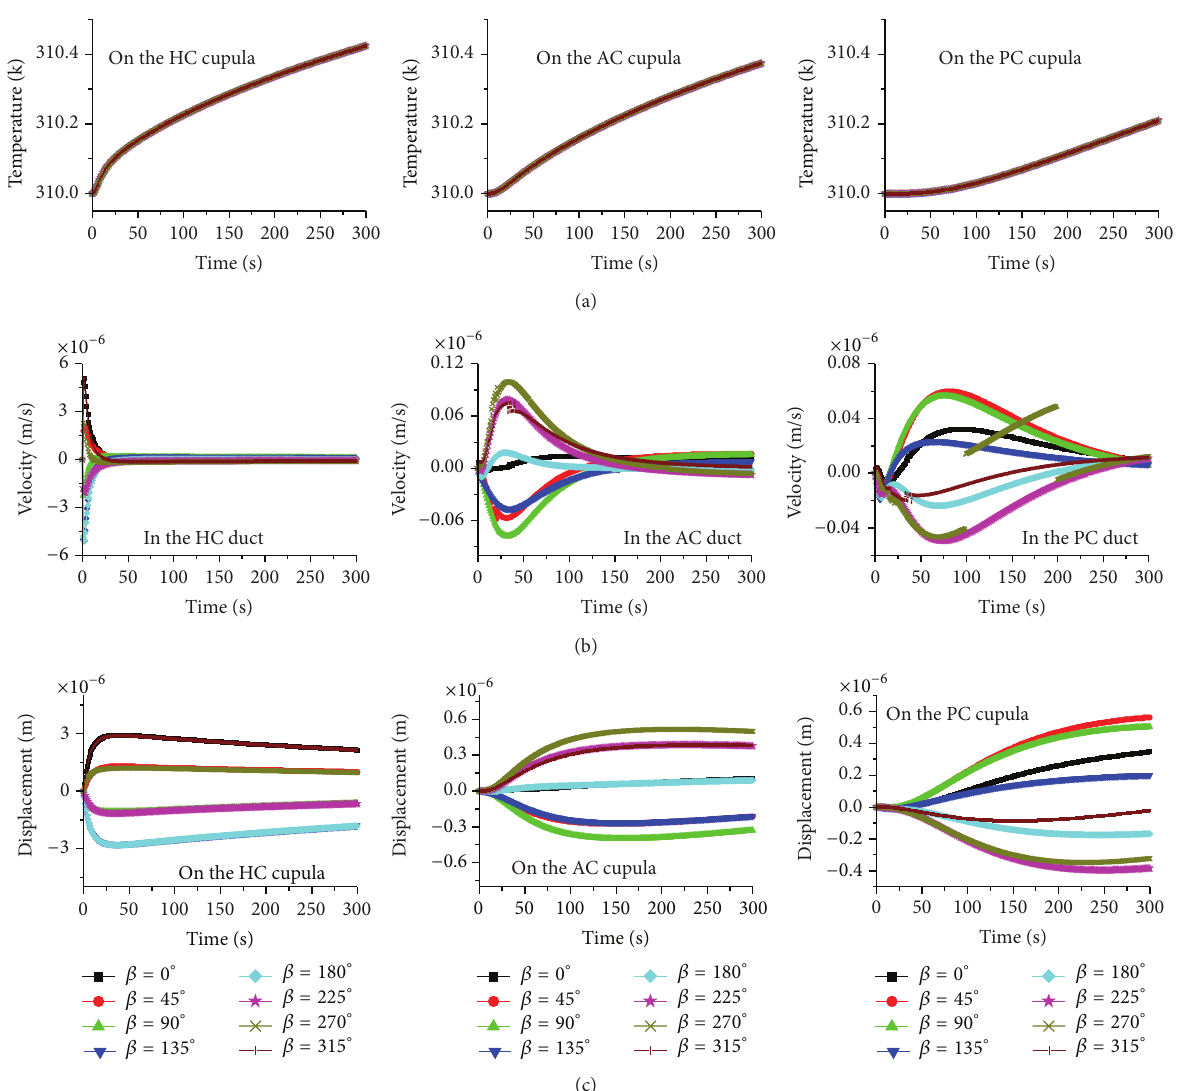
Figure 5: The effects of head position on the caloric responses when the gravity is parallel to the plane 𝛽 . (a) Temperature, (b) endolymph velocity, and (c) cupula